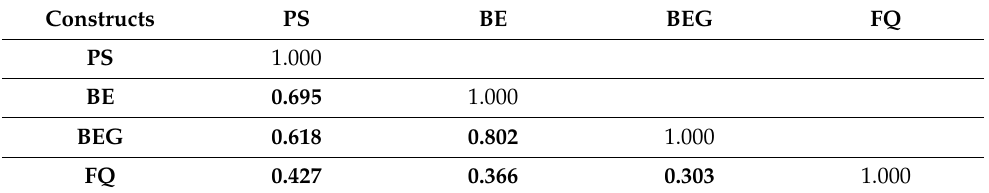
Table 3. HTMT result.